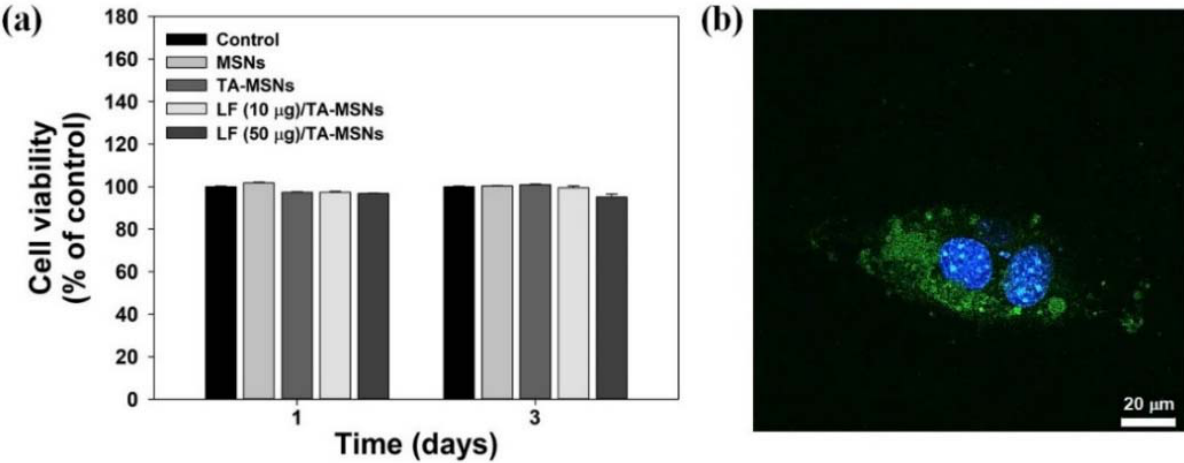
Figure 3. ( a ) Results of cytotoxicity assays following treatment of ADSCs with MSNs, TA-MSNs, LF (10 μ g)/TA-MSNs, or LF (50 μ g)/TA-MSNs at 1 and 3 days. ( b ) In vitro intracellular tracking of FITC-tagged MSNs after 4 h of culture. Green color indicates the intracellular uptake of FITC-tagged MSNs particles into cells, while blue color represents DAPI-stained nuclei of cells. Scale bar: 20 μ m.